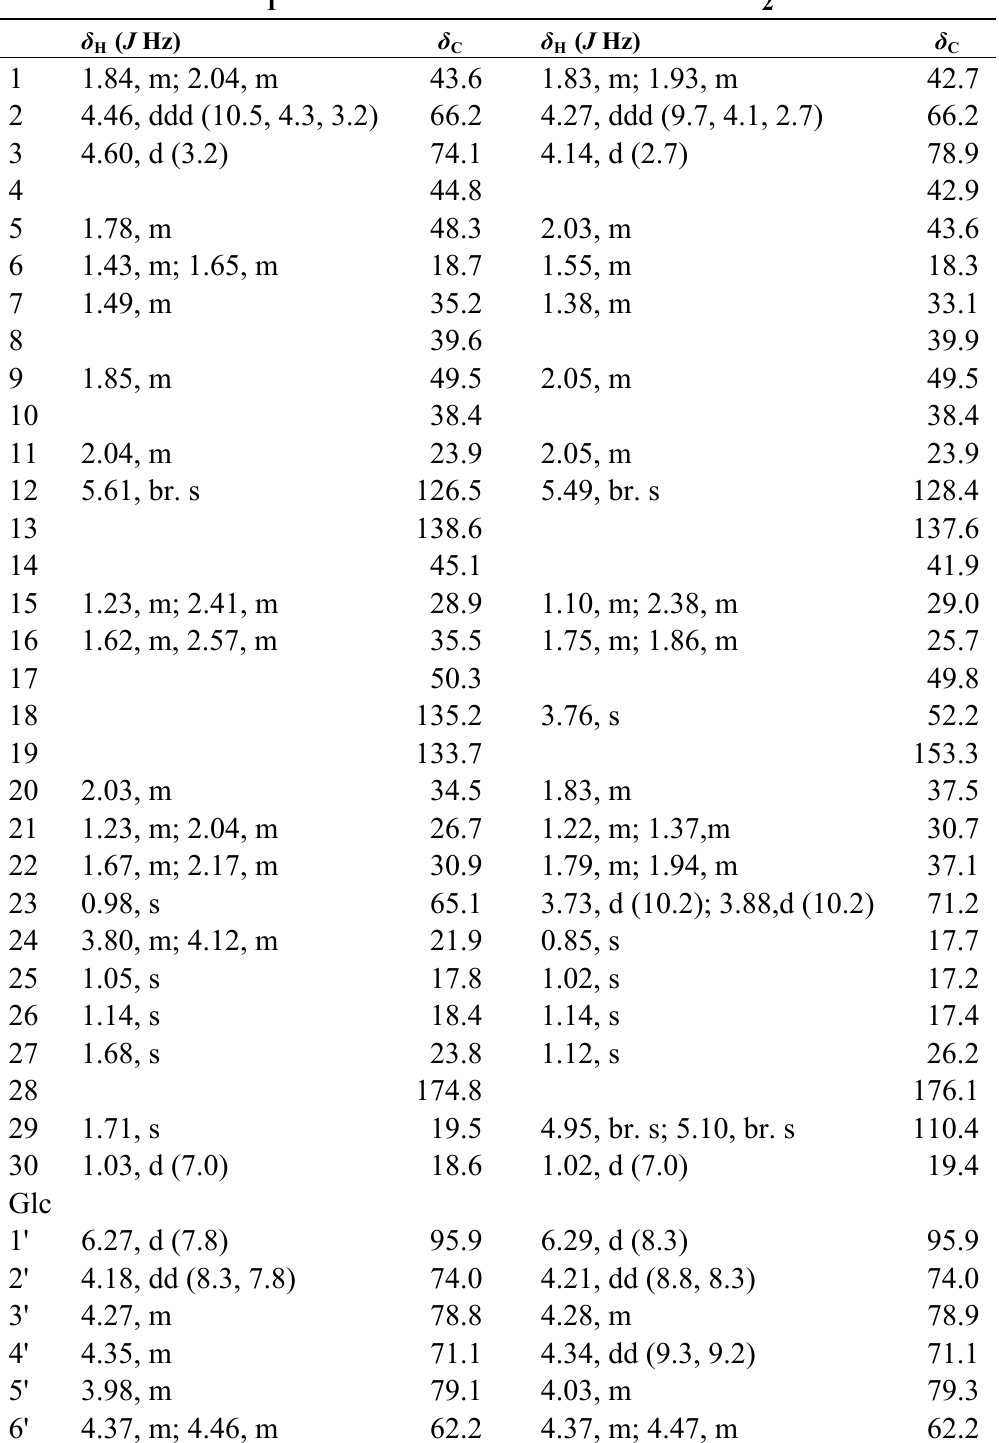
Table 1. 1 H- (600 MHz) and 13 C- (150 MHz) NMR data for 1 and 2 (in Pyridine- d